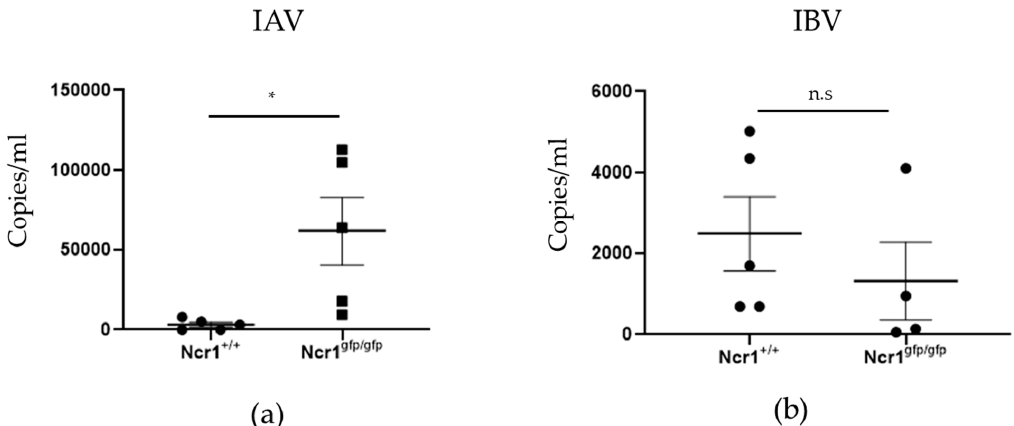
Figure 6. NCR1 is critical for the control of IAV but not IBV infection in vivo. Ncr1+/+ and Ncr1gfp/gfp mice were intranasally infected with IAV ( a ) or IBV ( b ). After five days, lungs were collected and real-time PCR was performed. n = 5 mice in each group. Values are shown as mean ± SEM. * p < 0.05 by two-tailed Student’s t test.